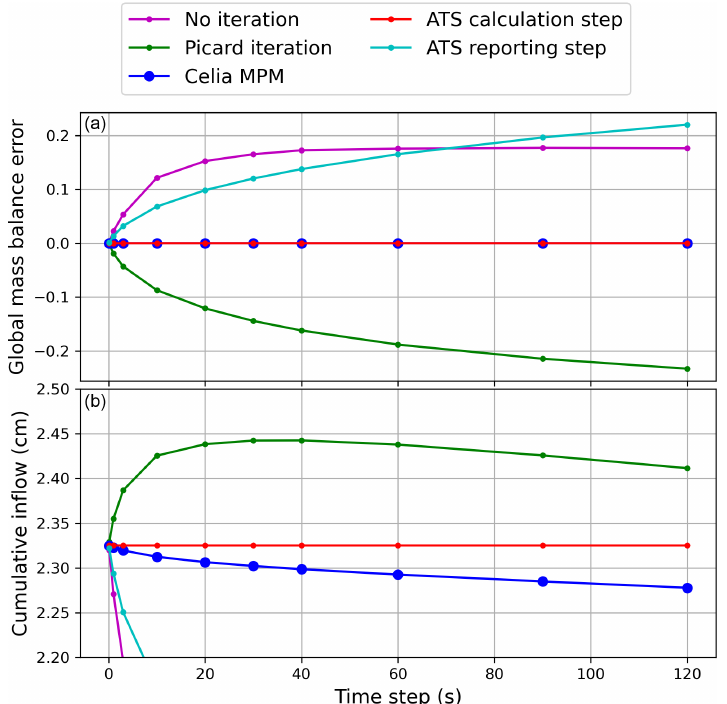
Figure 3. Mass balance of Celia’s three models and our adaptive time-stepping model. Panel (a) shows a reproduction of Celia’s mass balance calculation. Panel (b) shows the cumulative inflow that is simulated.